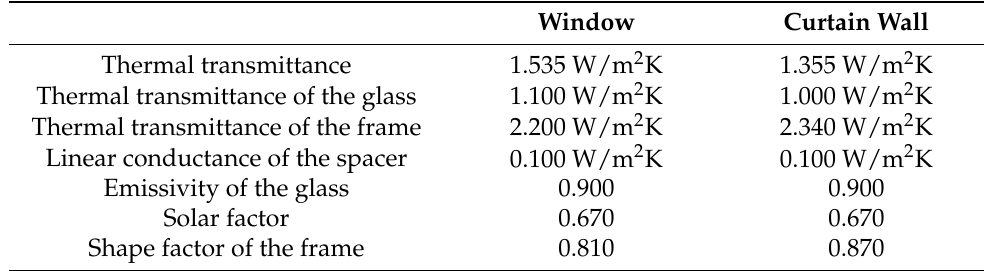
Table 9. Characteristics and main parameters of the building glazing elements.